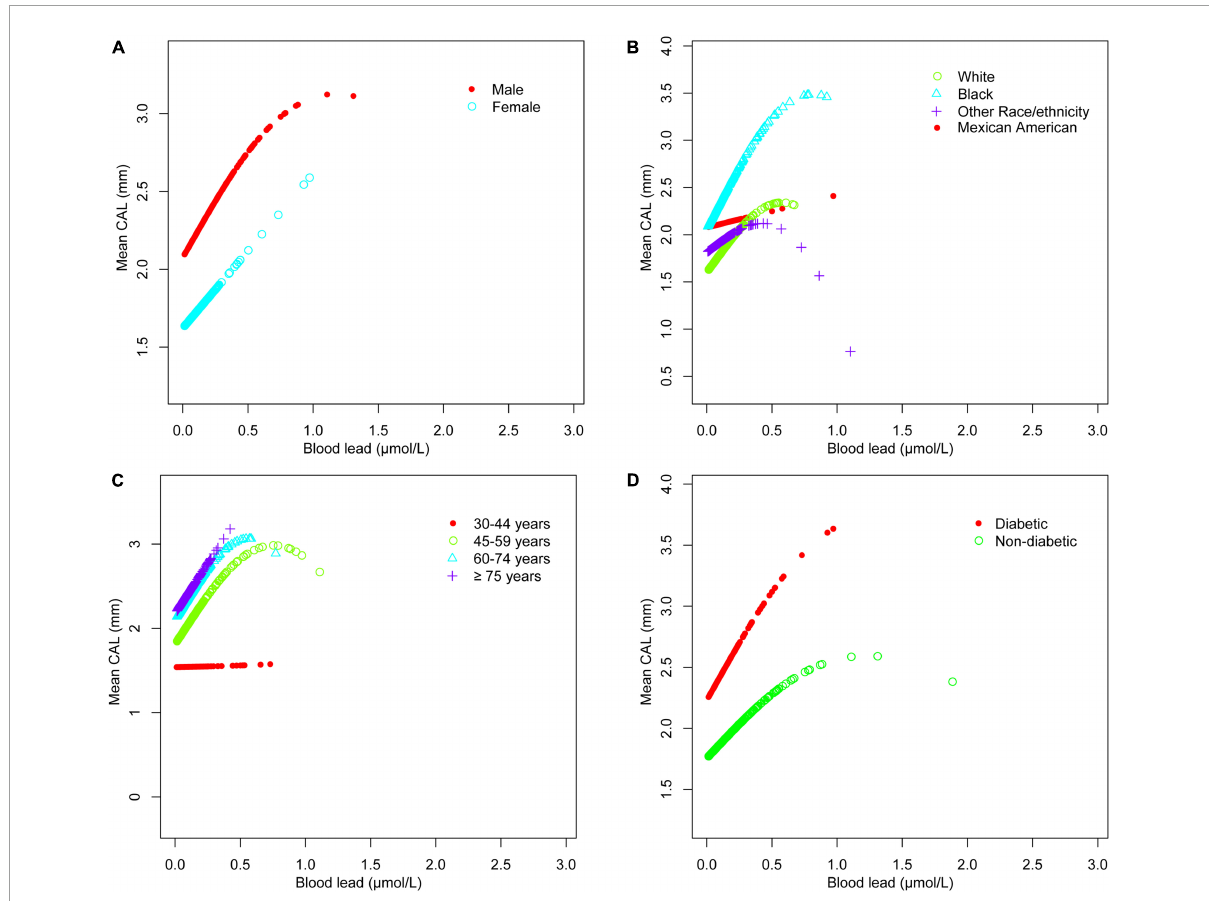
FIGURE3 Blood lead and mean CAL dose-response relationship. (A) Stratified by sex. (B) Stratified by race/ethnicity. (C) Stratified by age. (D) Stratified by diabetes history. Age, sex, race/ethnicity, BMI, income-poverty ratio, education, vitamin D, smoking status, diabetes, frequency per week using floss and mouthwash, periodontal treatment, hypertension, hyperlipidemia, BMD, congestive heart failure, coronary heart disease, angina pectoris, heart attack, stroke, physical activity, and calcium intake were adjusted. In the subgroup analysis stratified, the stratification variable itself was not adjusted.